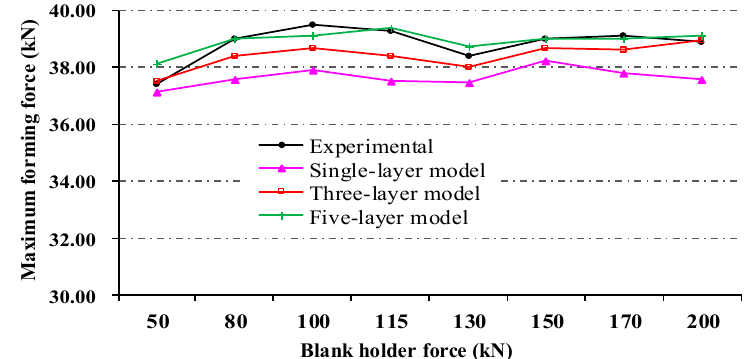
Figure 18. Comparison between numerical simulation results of maximum forming force and experimental results.